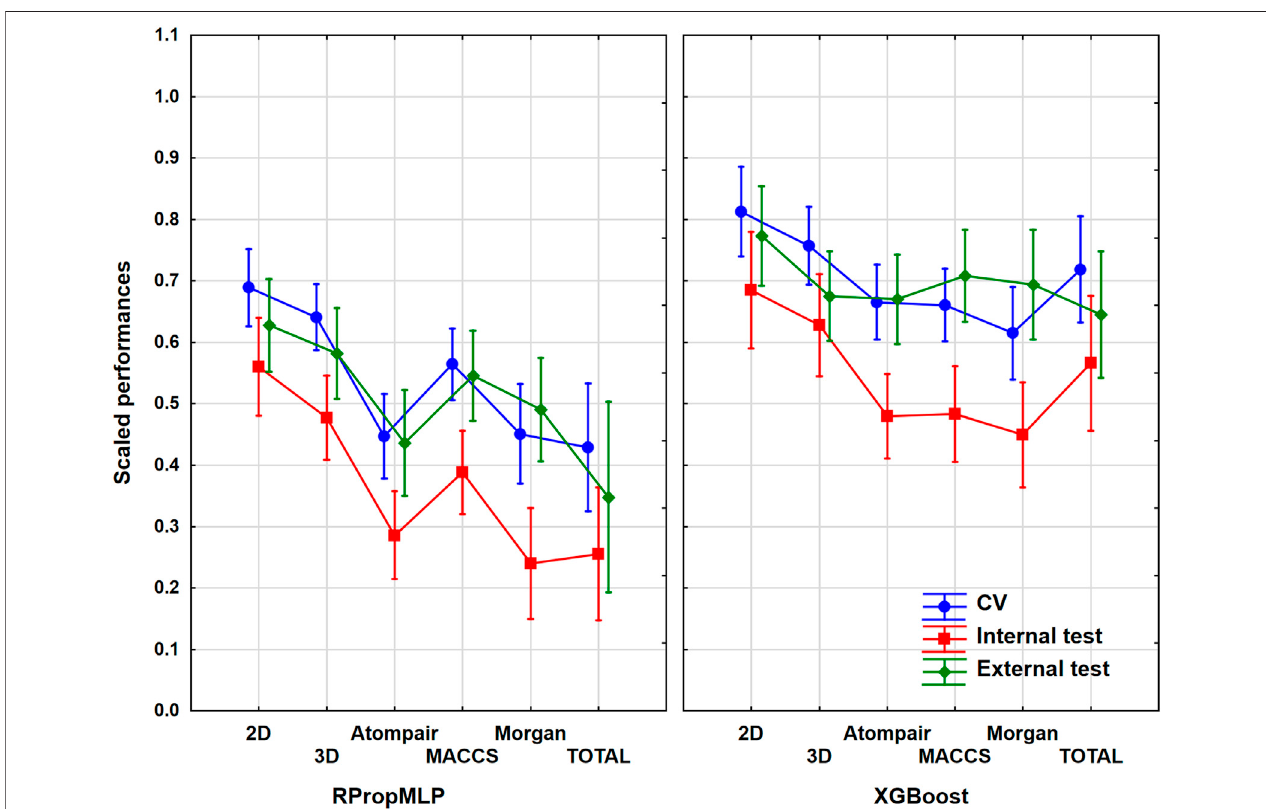
FIGURE3| Scaled performancesofthemodelsincase oftheCYP2C9dataset based onthemolecular descriptortypes and machinelearning algorithms. The18 performanceparameterswererange-scaledbetween0and1andaveragedacrossallmodelswiththegivendescriptortypes/MLalgorithms.TheresultofCVismarked with blue, the internal test result is marked with red, and the external test is marked with green. The mean is plotted in each case with the 95% con fi dence intervals.